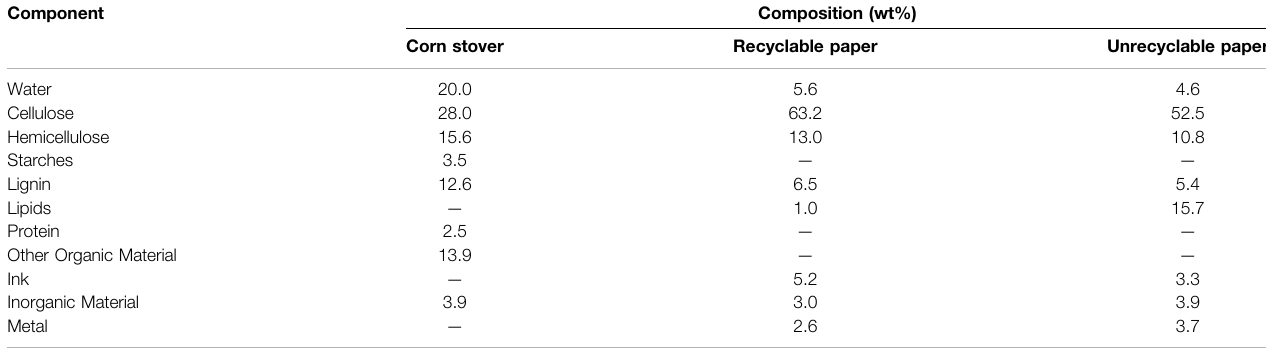
TABLE 1 | Typical compositions of raw corn stover and recycle paper.